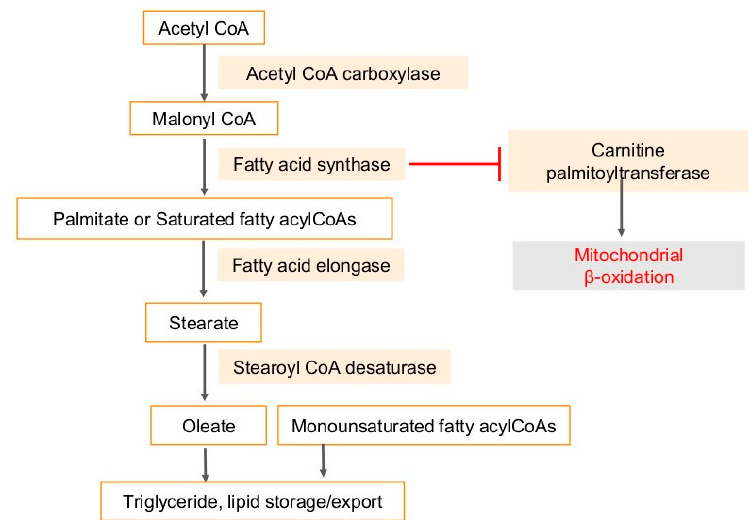
Figure 4. Triacylglycerols are synthesized from acetyl-CoA. Acetyl-coA is metabolized